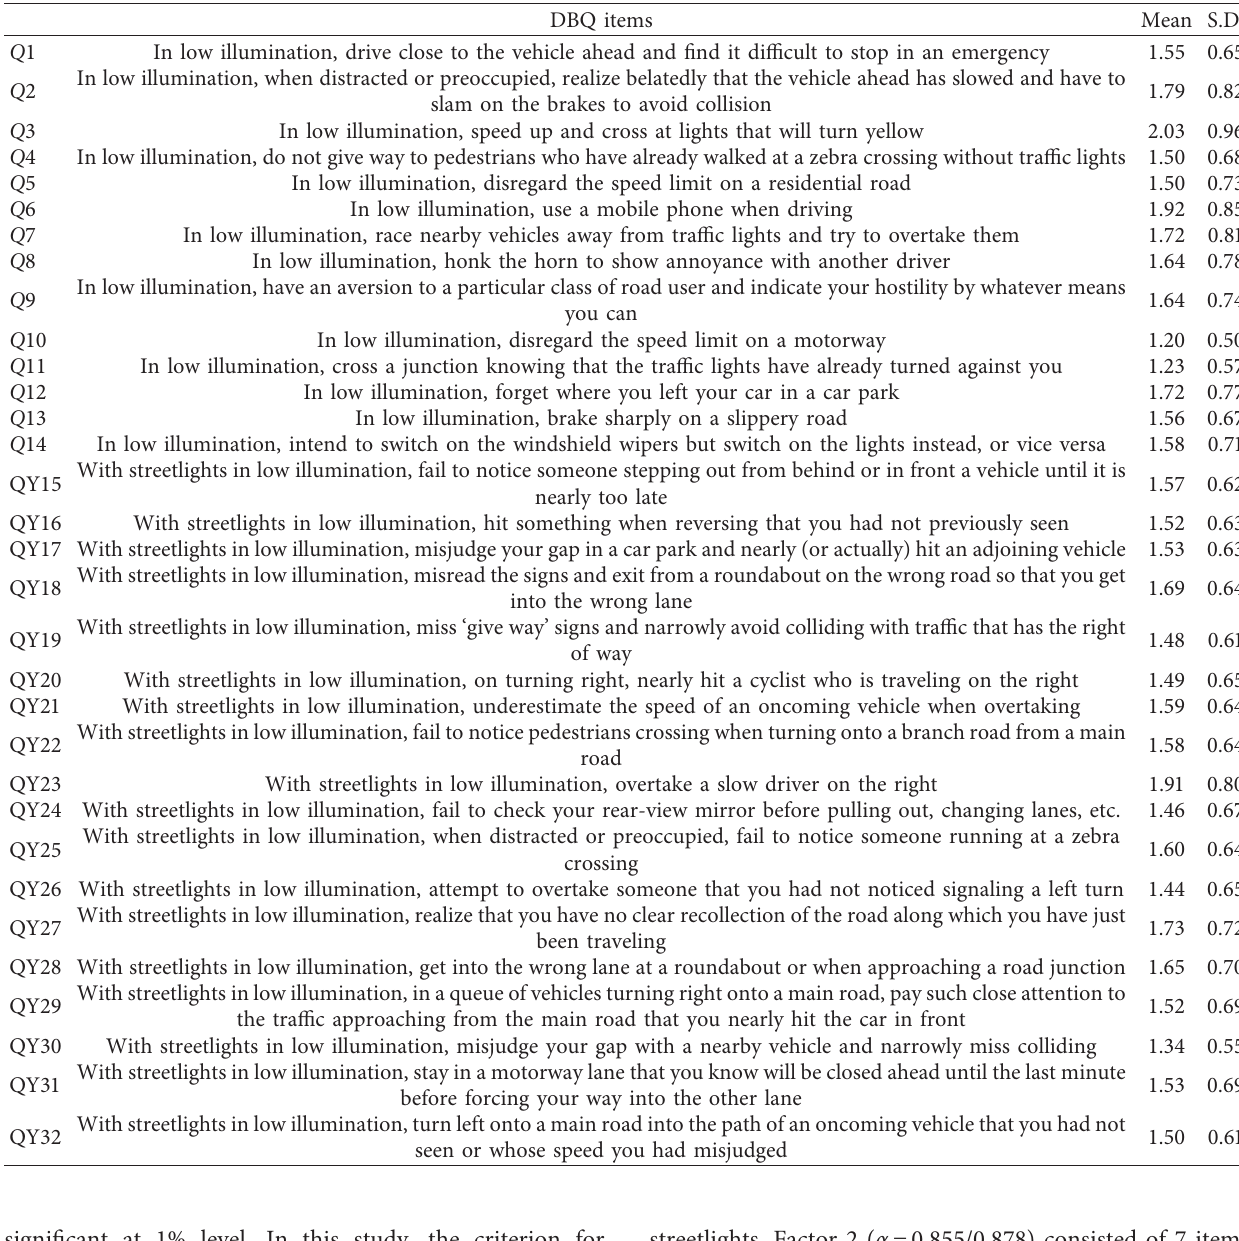
Table 1: Summary of the results for the DBQ with streetlights in low